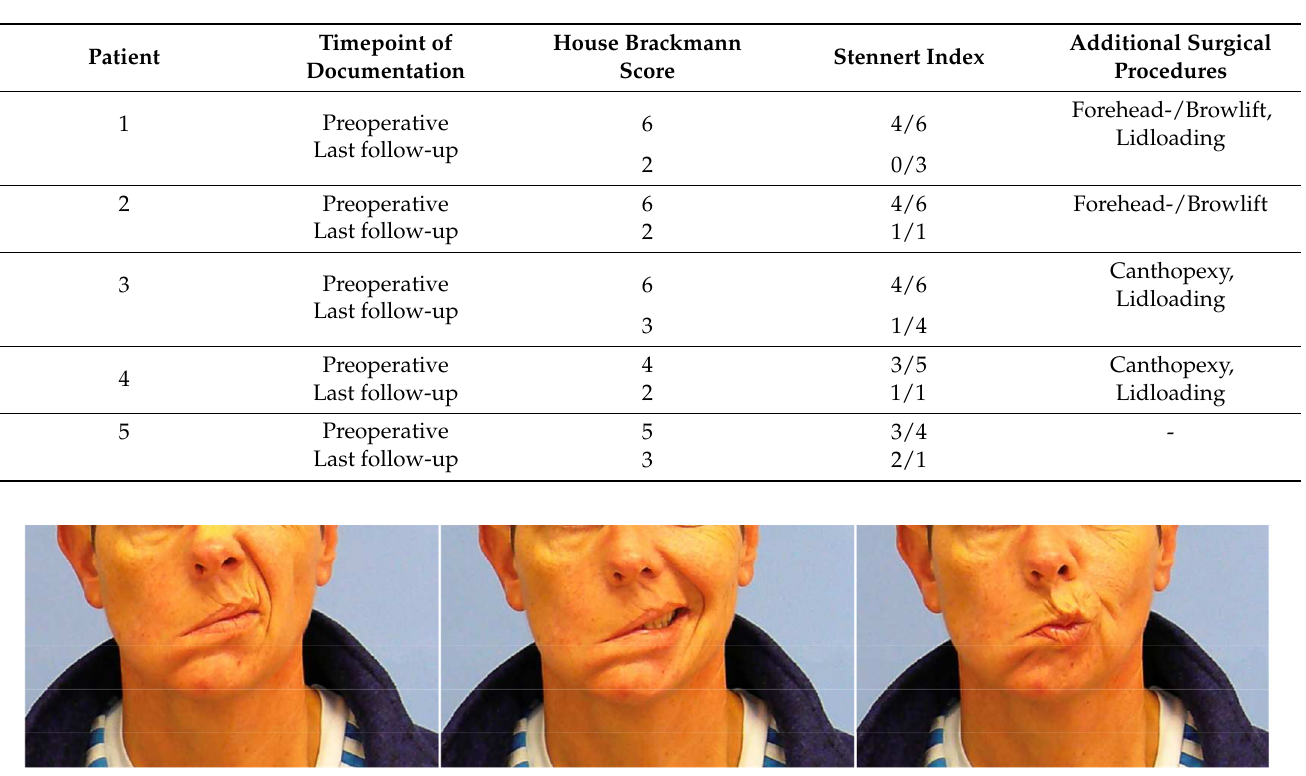
Figure 5. Preoperative excursion of the mouth in patient 4. Left: wrinkling the nose; center: smiling; right: pointing the mouth.